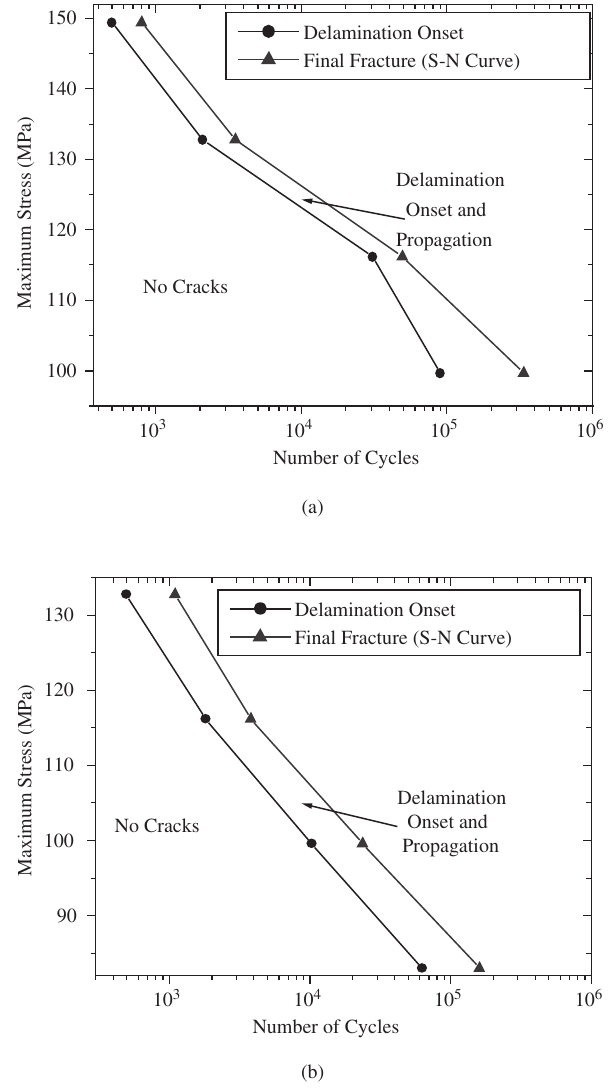
Figure 6. Damage Formation and Propagation Diagrams (DFPD) for laminate (a) C10 and (b) C12 with R = 10.